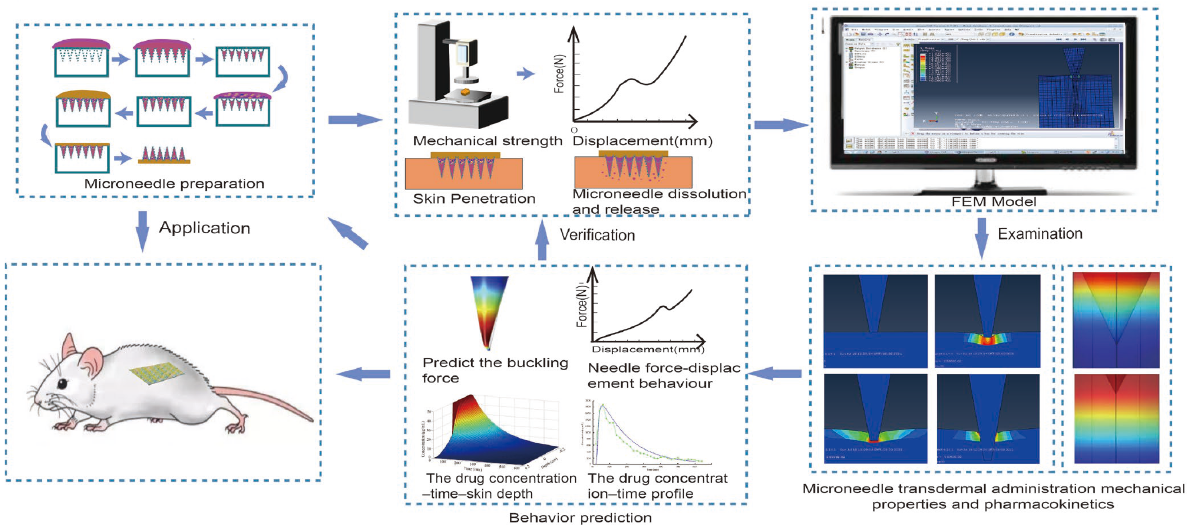
Figure 9. Conceptual diagram of FEA simulation for MNs TDDS.